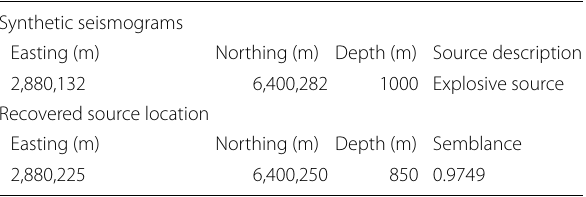
Table 1 Summary of semblance location for synthetic waveforms from an isotropic